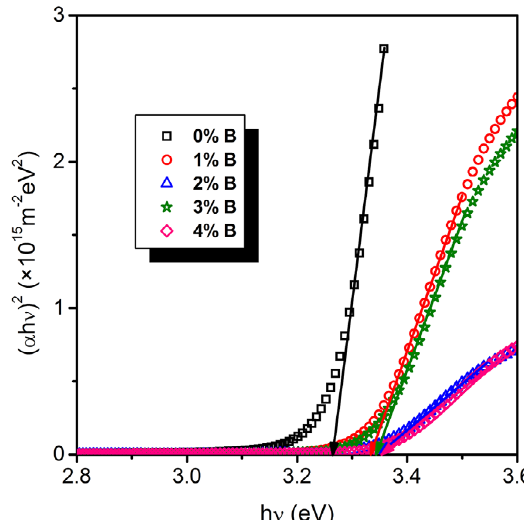
Figure 4. Optical transmittance spectra of the B-N codoped ZnO thin films deposited by spray pyrolysis technique with various B concentrations.